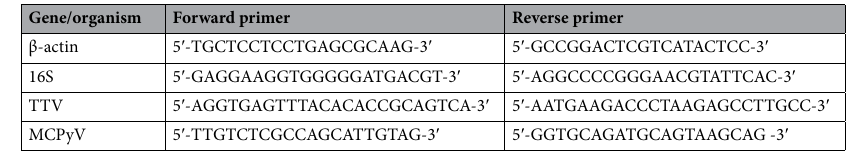
Table 1. PCR primer